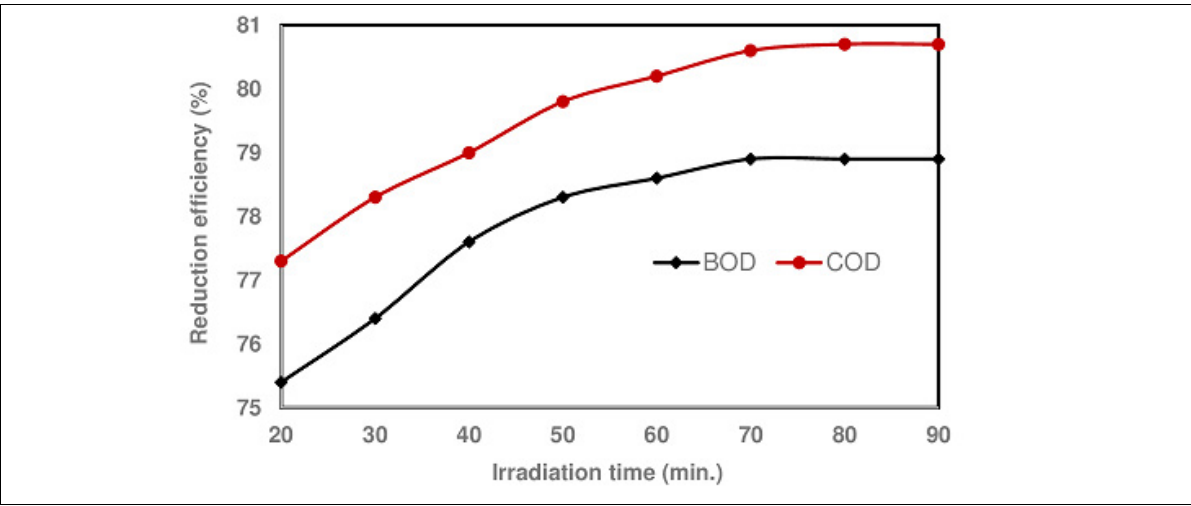
Figure 2: Effect of the initial concentration of the edible oil wastewater (EOW) on the reduction efficiency of biological oxygen demand (BOD oxygen demand (COD).